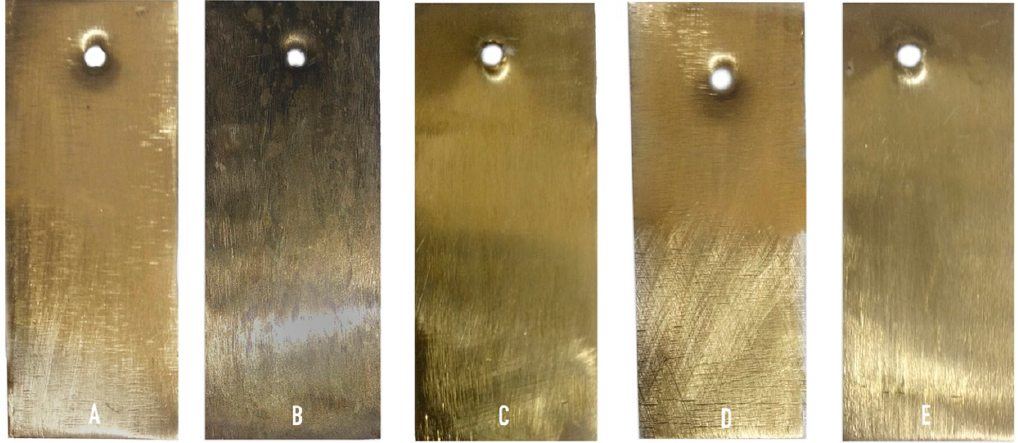
Figure 2. Brass samples before ( A ) and after salt spray corrosion testing without an inhibitor ( B ), and in the presence of 3-mercaptobutyl-5-amino-1 H -1,2,4-triazole at concentrations of 1 ( C ), 5 ( D ), 10 mM ( E ).